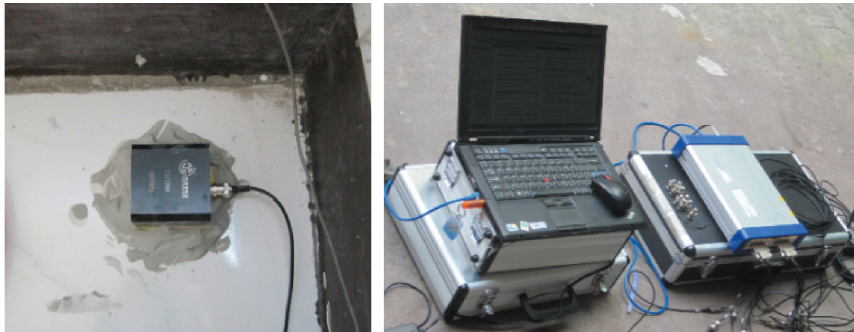
Figure 11: Photographs showing measurement